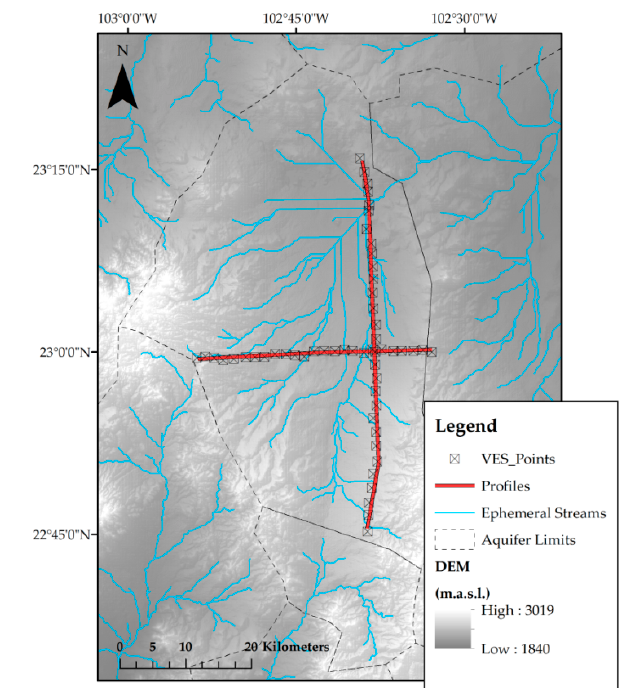
Figure 4. Location map of the VES (vertical electrical sounding) using a square transmitter of 200 m × 200 m.